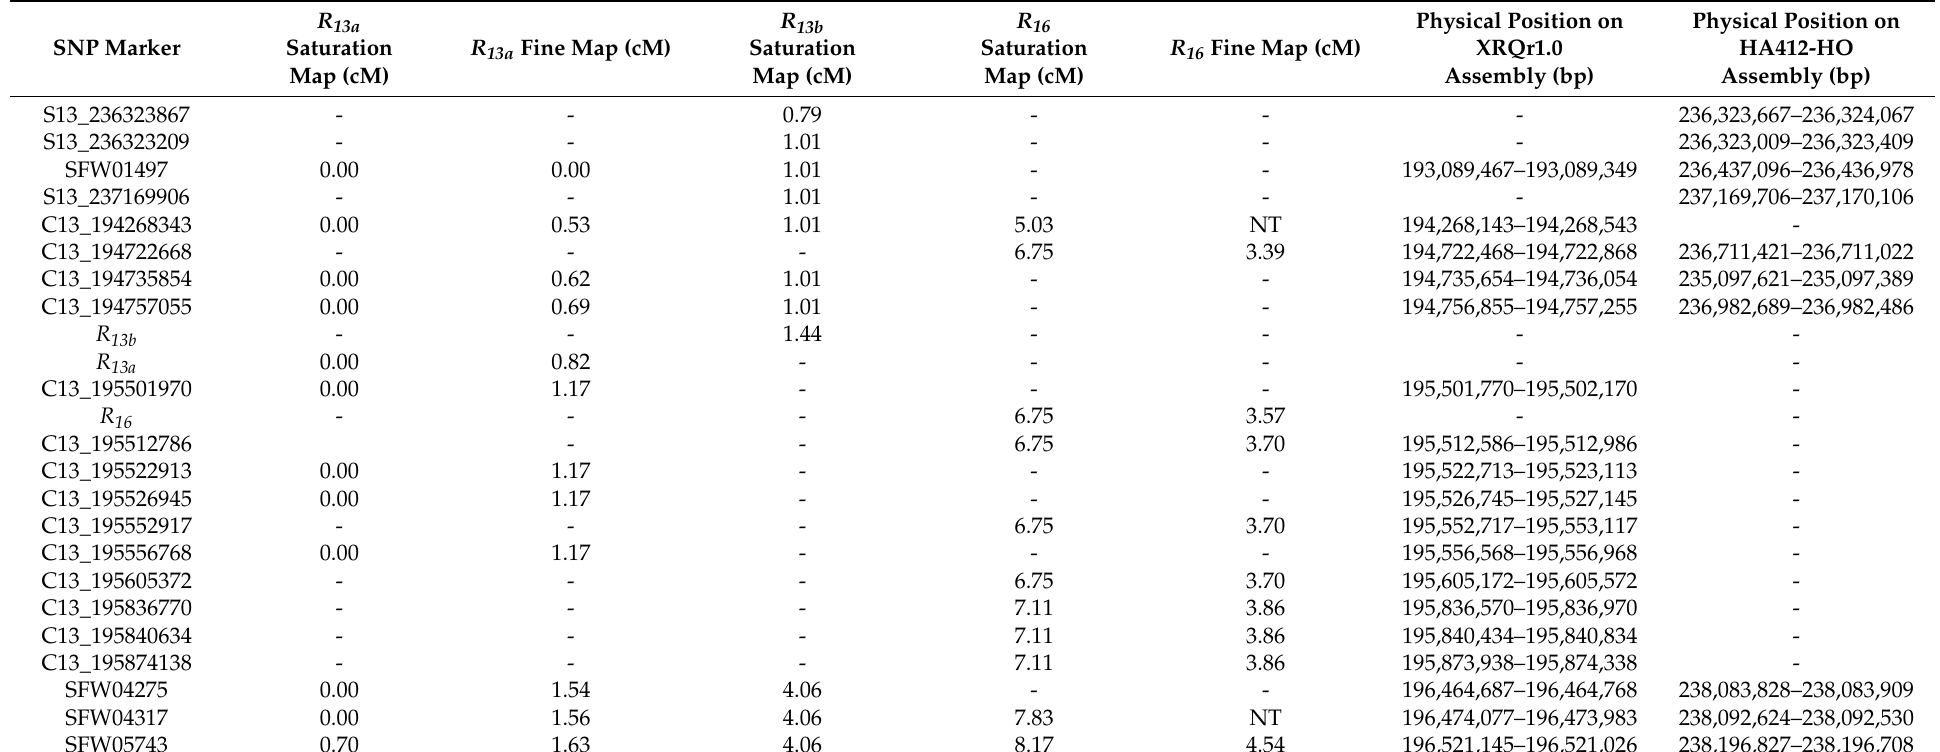
Table 4. Map positions of the SNP markers linked to R 13a , R 13b , and R 16 on sunflower chromosome